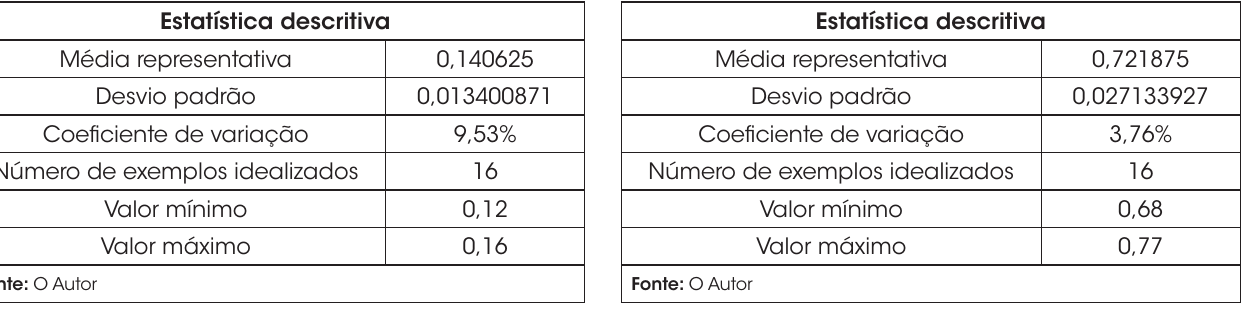
Na figura 7, pode-se visualizar o gráfico de distribuição de Gauss x Histograma e, na tabela 10, estão dispostos os valores da média representativa, desvio padrão, coeficiente de variação e valores de máximo e mínimo.